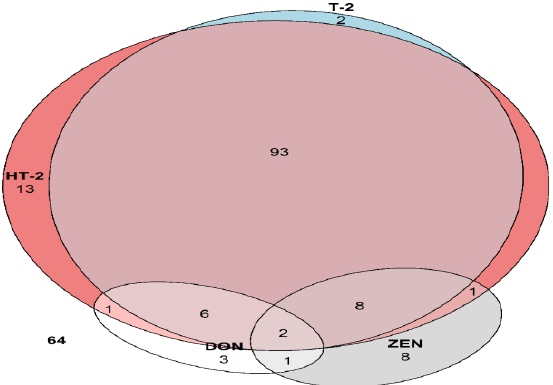
Figure 2. Euler diagram of deoxynivalenol (DON), HT-2 toxin (HT-2), T-2 toxin (T-2), and zearalenone (ZEN) detections.